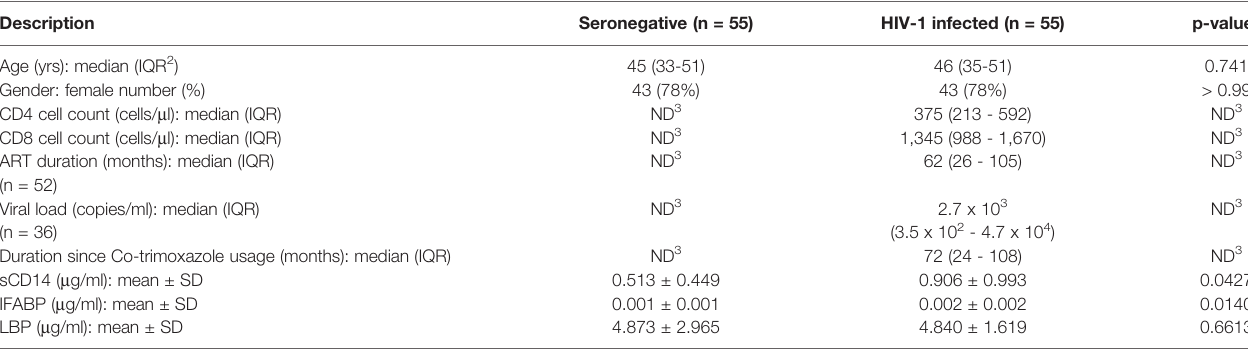
TABLE 1 | Clinical and demographic